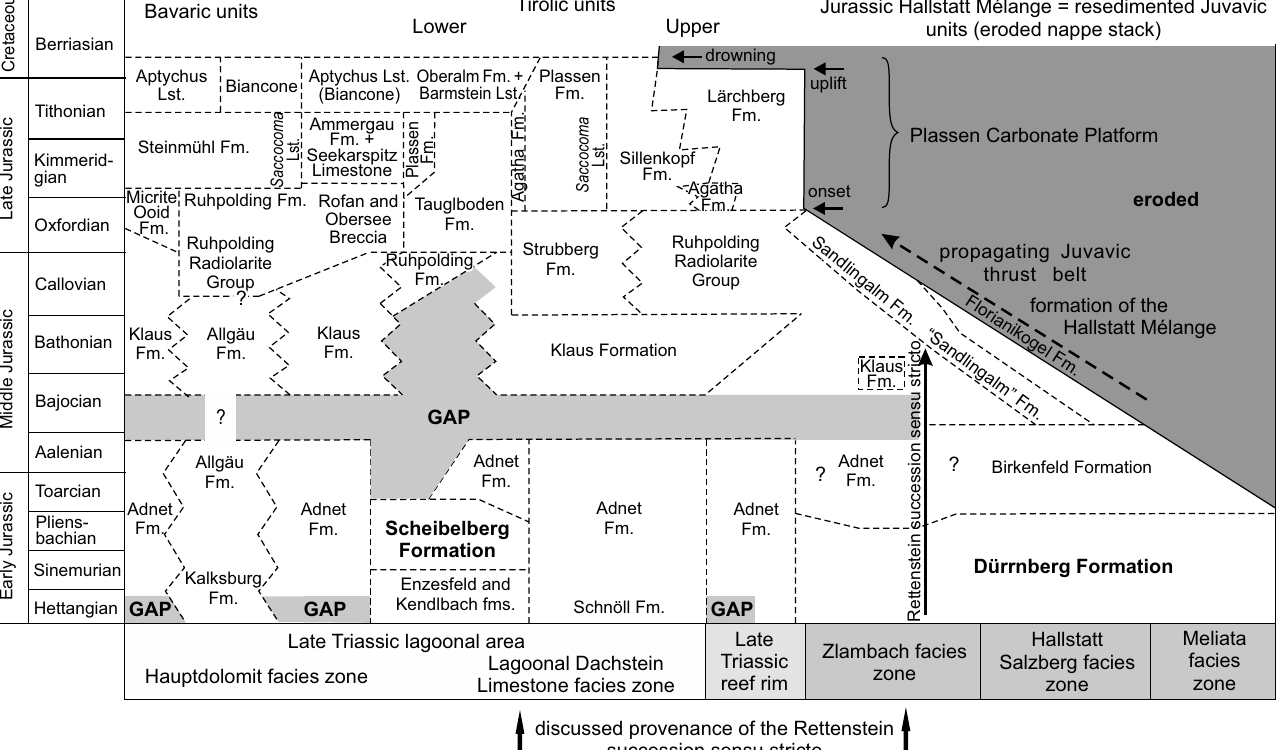
Fig. 2. Stratigraphic table with lithostratigraphic names and main tectonic events of the Jurassic of the Northern Calcareous Alps with their variations depending on the palaeogeographic position (after Gawlick et al. 2009). The different facies belts and therefore also the formations belong to depositional realms, which roughly correspond to the later formed tectonic units. The outer shelf region can only be reconstructed from blocks in Middle to Upper Jurassic mélanges and is, therefore, not completely understood in all details. The grey limestone succession from Mount Rettenstein shows characteristics of both the Scheibelberg and the Dürrnberg formations (in bold). Estimated palaeogeographic positions of the studied section are indicated. Abbreviations: Cret., Cretaceous; Fm., Formation; Lst.,